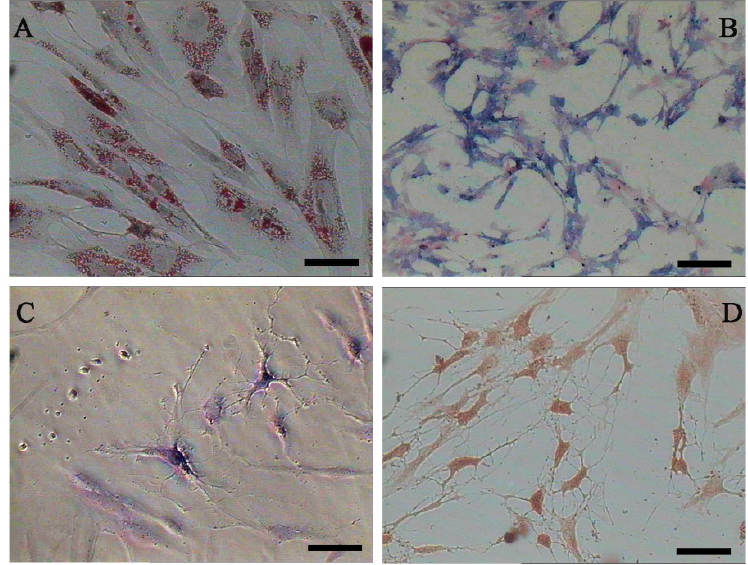
Figure 4. Adipogenic, osteogenic and neurons differentiation of AD-MSCs. ( A ) Oil red O staining positive; ( B ) Alkaline phosphates staining positive; ( C ) Nissl’s body staining positive; and ( D ) Immunocytochemical staining positive for NSE (neuron-specific enolase). Scale bars, 100 μ m. (Original magnification, ×100).